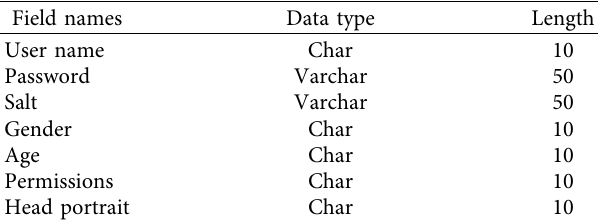
Table 1: User information table.